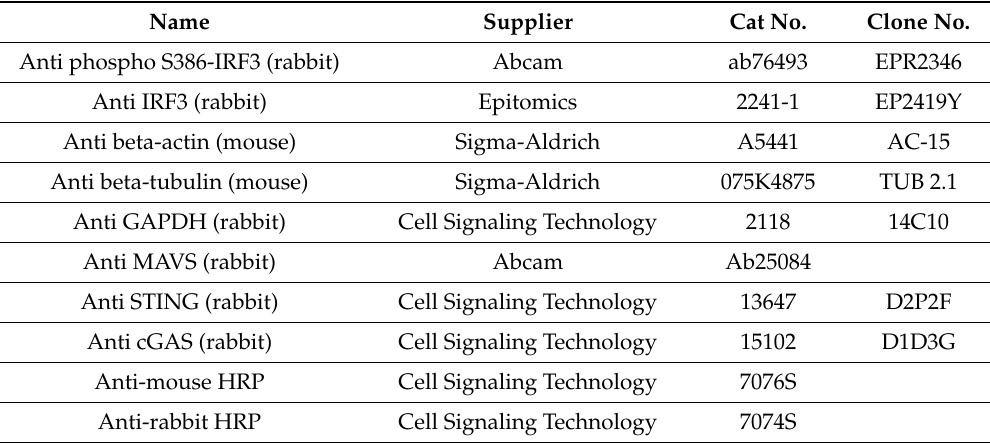
Table 4. Antibodies used for Western